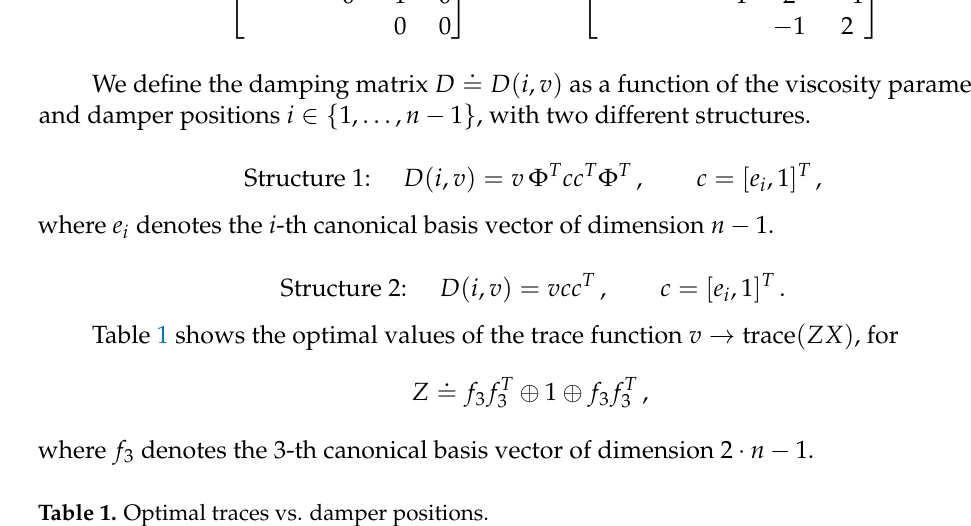
Table 1. Optimal traces vs. damper